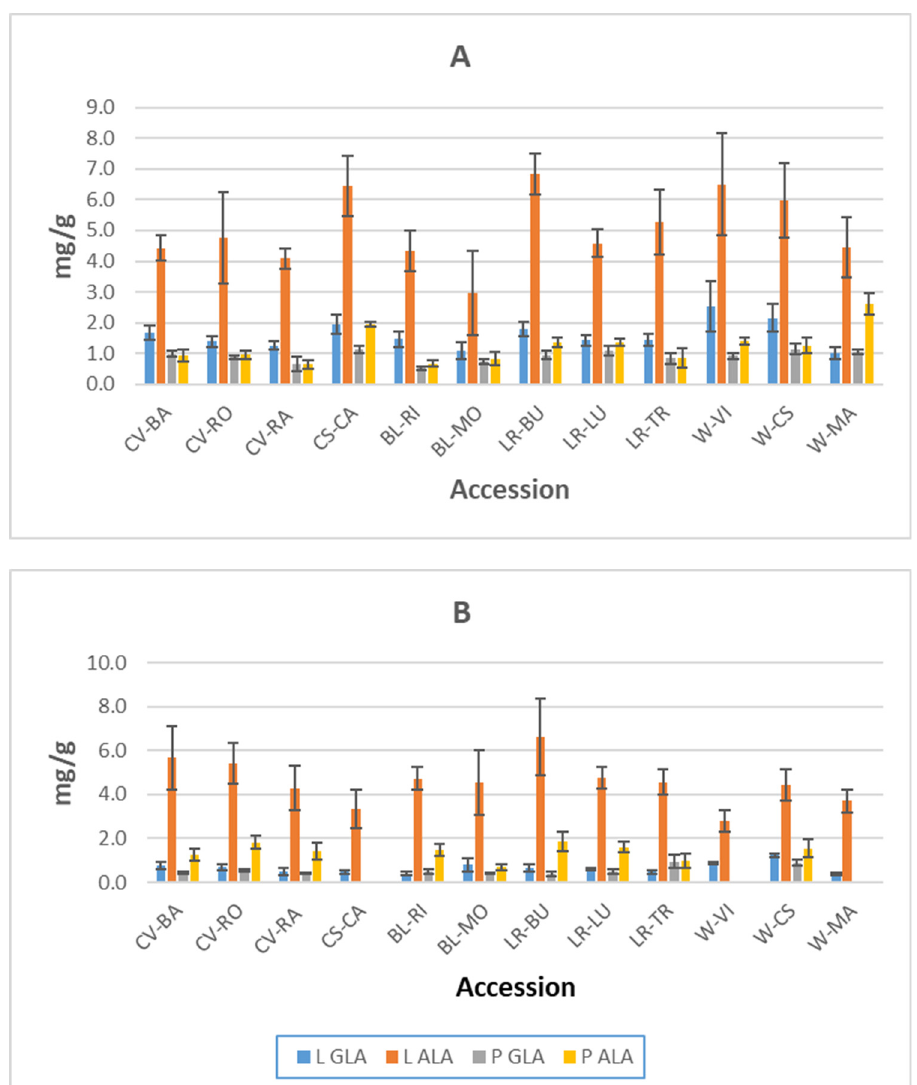
Figure 4. γ -linolenic acid (18:3 n6, GLA) and α -linolenic acid (18:3 n3, ALA) contents (mg/g of dry weight) in leaf blades (L) and petioles (P), sampled 120 days after sampling ( A ) and 150 days after sampling ( B ) (LOQ = 0.260 mg/g and LOD = 0.078 mg/g). Samples without values mean sessile leaves at this plant-growing period. Samples without values mean sessile leaves at this plant-growing period.